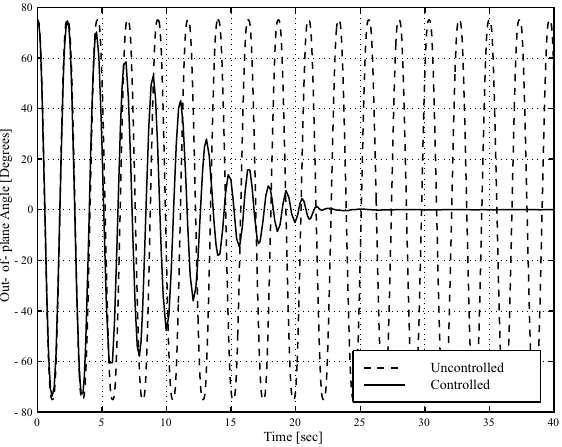
Fig. 26. Uncontrolled vs controlled out-of-plane oscillation angle θ ( t ) for the damping case using the fuzzy